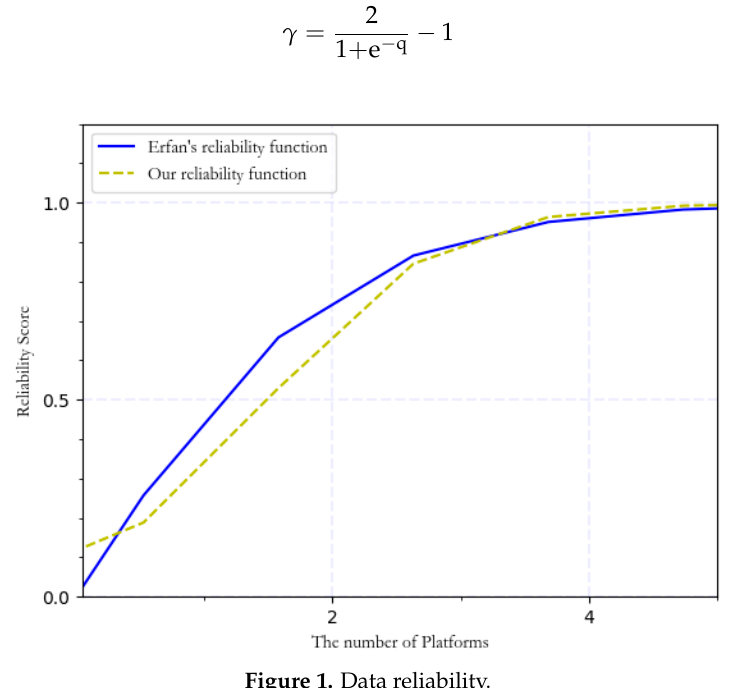
Figure 1. Data Figure 1. Data reliability.